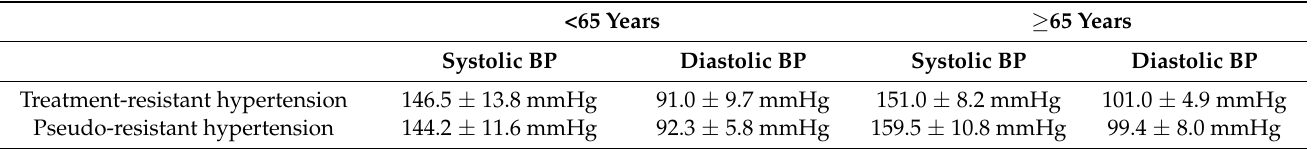
Table 5. Age-stratified mean blood pressure in hypertensive patients with TRH and